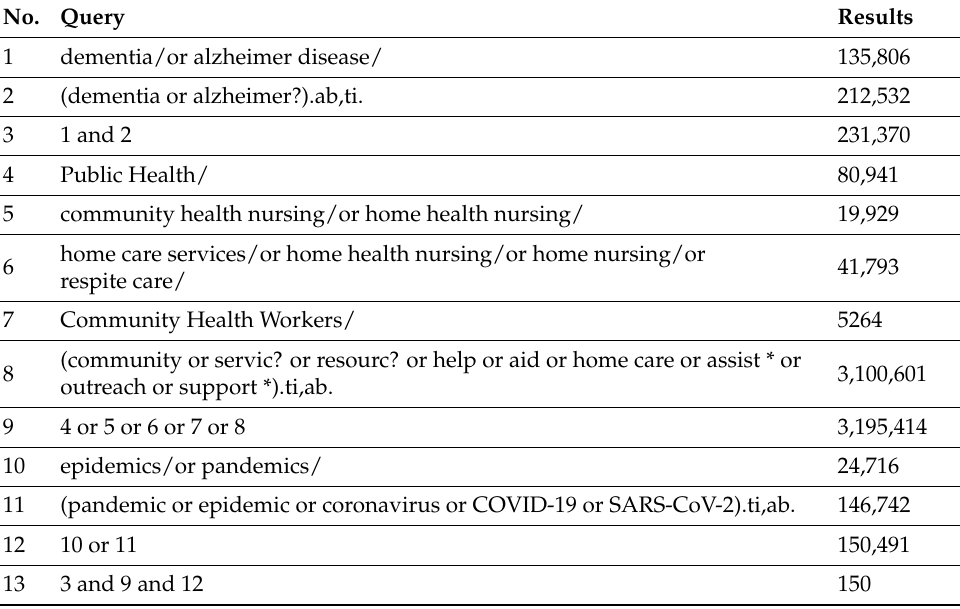
Table A1. Ovid (Medline). Date of search: 7 July 2020.